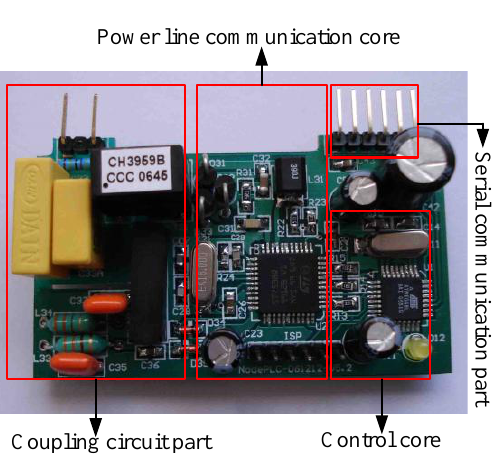
Figure 15. PLC terminal